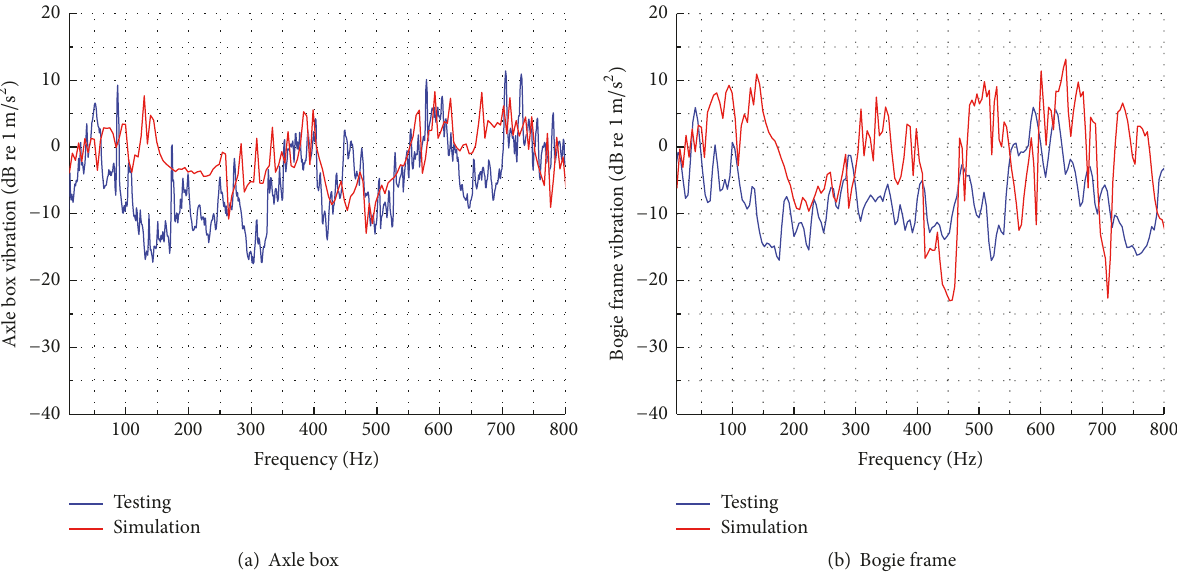
Figure 9: Vibration comparison of testing and simulation (in frequency domain).